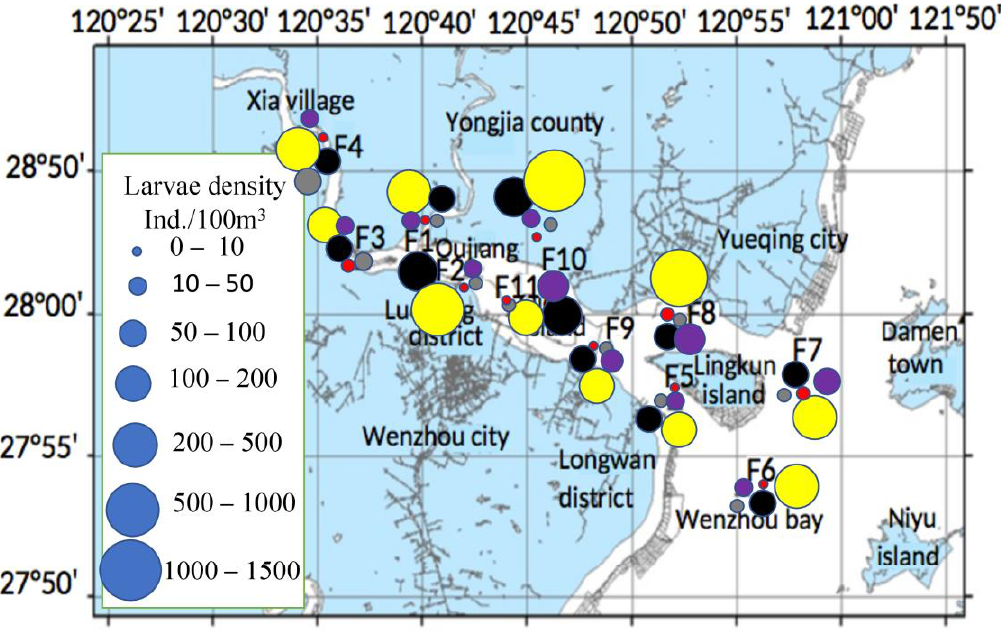
Figure 2. Spatial-temporal distribution of fish larvae in Oujiang River Estuary: each sampling month is indicated with a specific color: red = April, black = May, yellow = June, grey = July and purple = August. The size of circle reflects the density of larvae in a specific site.